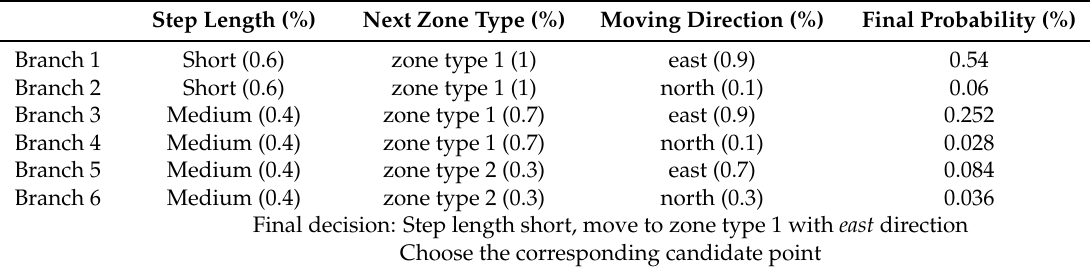
Figure 10. The fuzzy decision tree used in the proposed system with the knowledge-based rules and map information. map information. Table 4. One of the possible situation in FDT system. Table 4. One of the possible situation in FDT